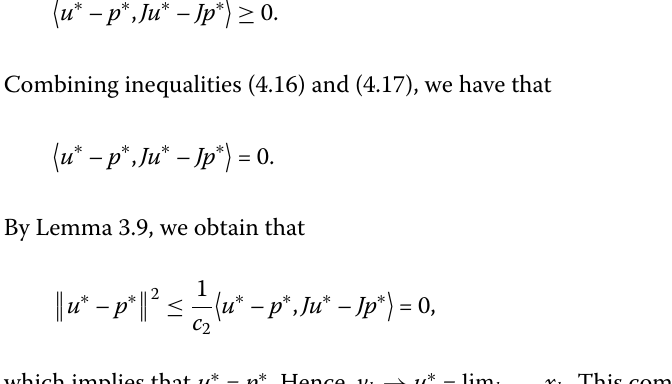
Algorithm 2 Let { v k } ∞